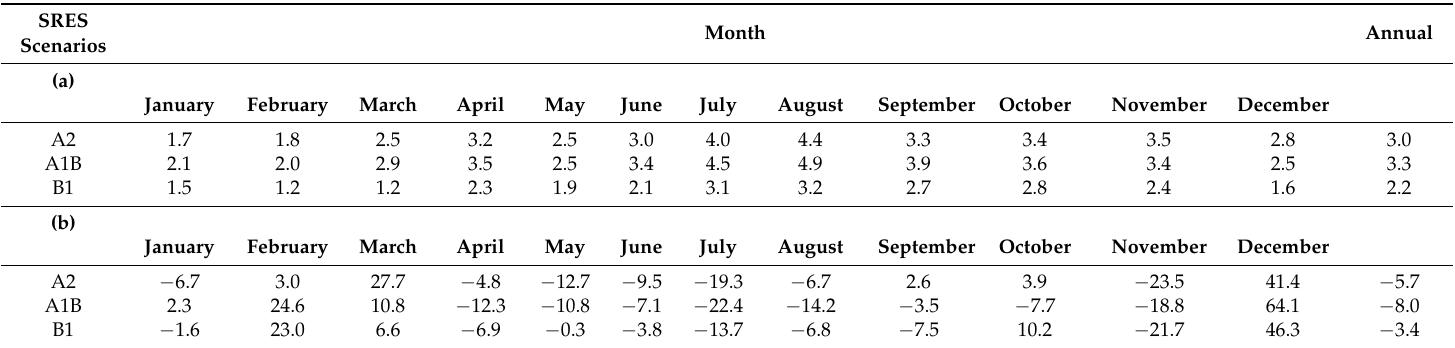
Table A1. Projected climate change scenarios (based on the Special Report on Emission Scenarios, SRES, IPCC 2007, CMIP 3 † ) for the mid-21st century (2046–6205) in the Skunk Creek Watershed (SKW). ( a ) Change in annual and monthly temperature (magnitude) with respect to the baseline (1987–2000); ( b ) Change in annual and monthly precipitation (in percentage) with respect to the baseline (1987–2000).